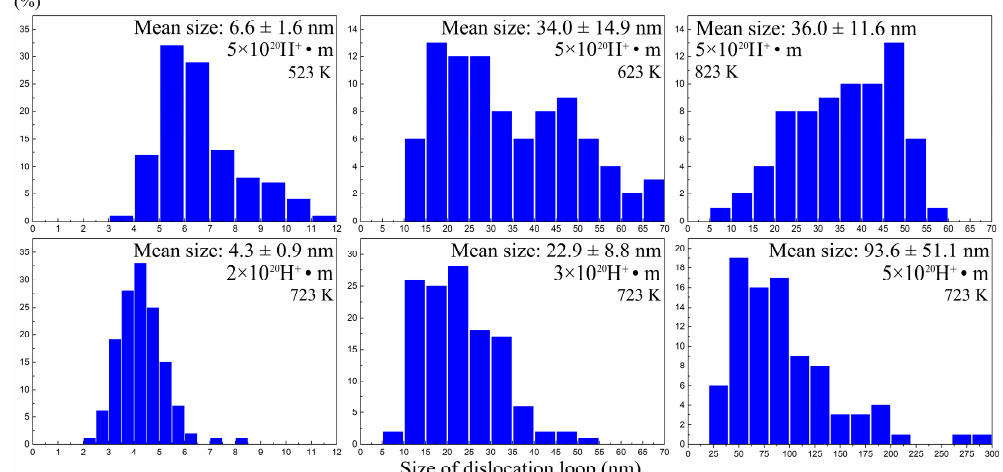
Figure 7. The size distributions of the dislocation loops in all of the specimens. Below each value of the mean size, the corresponding standard deviation is added.